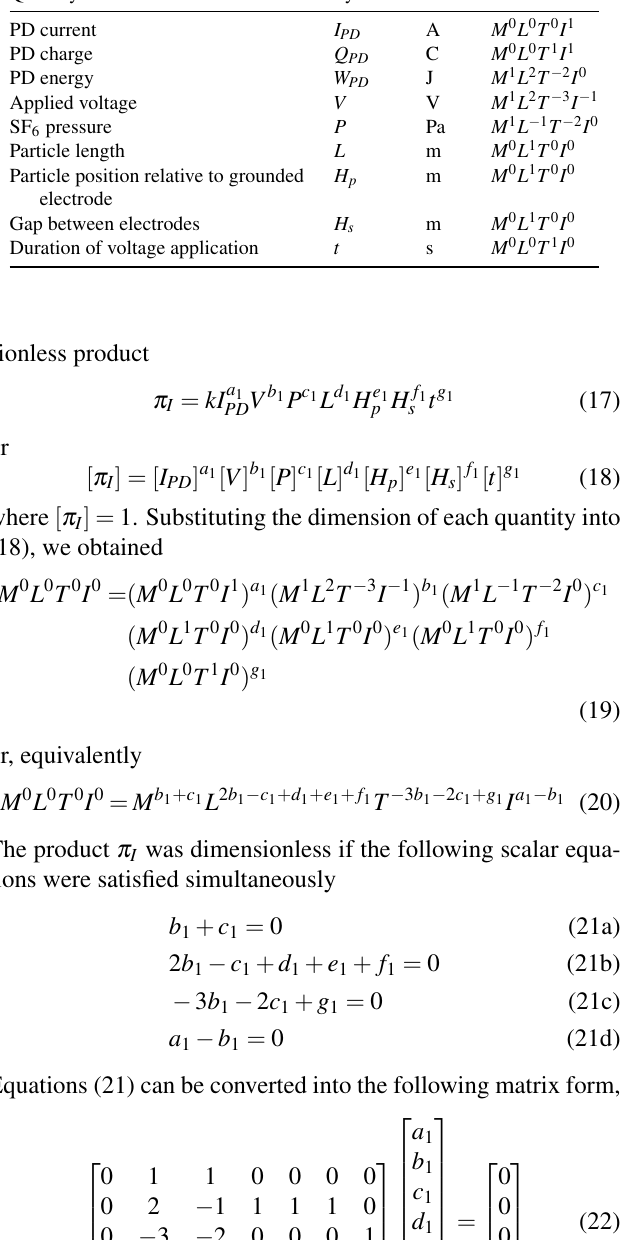
Table 1. Dimensions of GIS quantities to be inter-related by DA Quantity